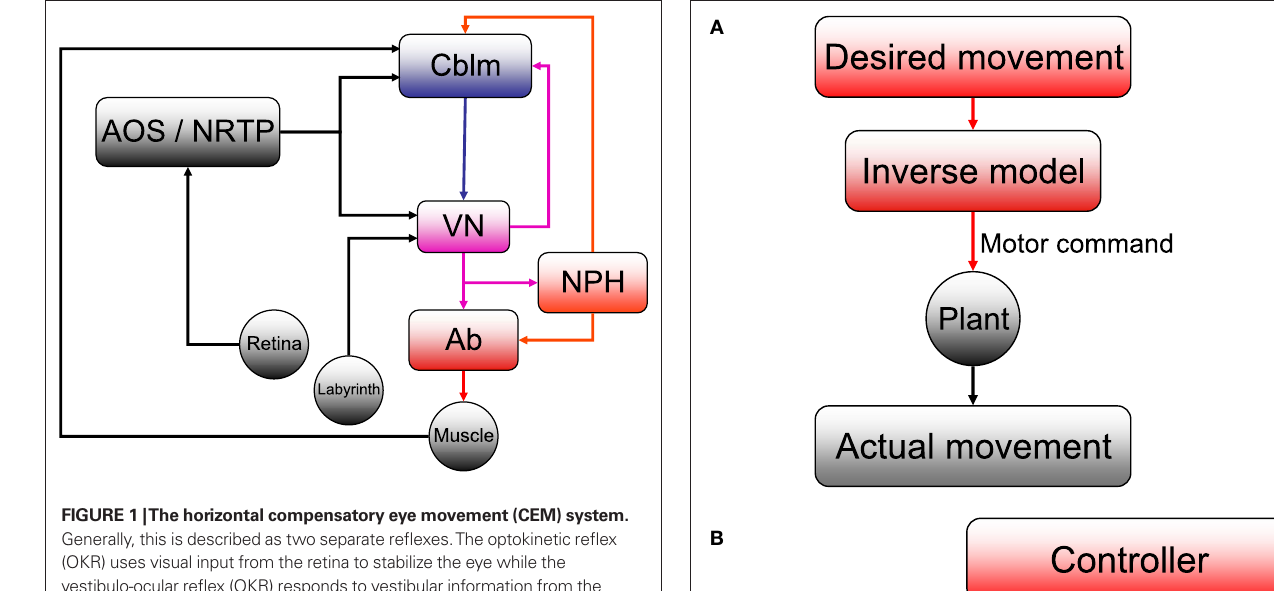
FIGURE 1 | The horizontal compensatory eye movement (CEM) system. Generally, this is described as two separate refl exes. The optokinetic refl ex (OKR) uses visual input from the retina to stabilize the eye while the vestibulo-ocular refl ex (OKR) responds to vestibular information from the labyrinth. This fi gure emphasizes the distinction between sensory feedback (black) and motor signals (red).Blue and purple represent central stages of processing, and are added for comparison with other fi gures. Cblm: cerebellar cortex; AOS/NRTP: accessory optic system and nucleus reticularis